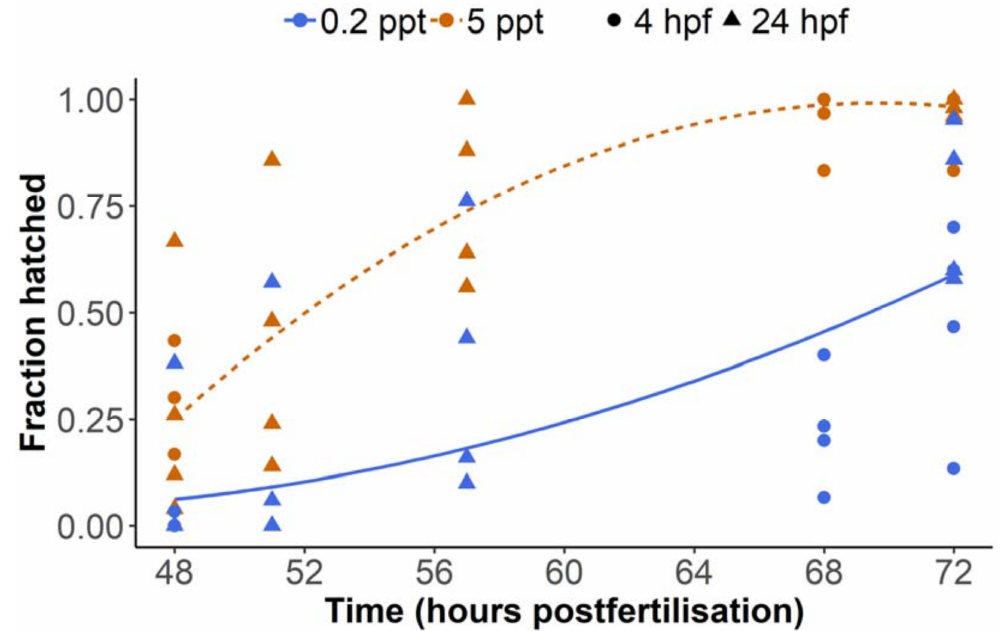
Figure 3. Proportion of zebrafish embryos hatched between 48- and 72-h post-fertilisation while exposed to salt concentrations of 0.2 (blue) or 5 ppt (orange) in petri dishes at 25 ◦ C, beginning from either 4 hpf (circles) or 24 hpf (triangles) depending on the experiment. N = 8 dishes of 30 embryos per salt concentration, with each point representing a single dish. Curve fits derived from a linear mixed effects model (time as quadratic